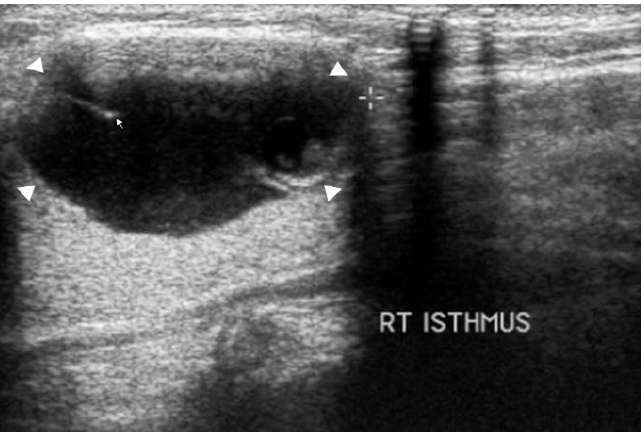
Figure 14. Neck ultrasound of enlarged cervical lymph nodes from a patient with papillary thyroid cancer. The enlarged node is oval in shape, very hypoechoic and contains a few of the blotchy microcalcifications typical of papillary cancer. The arrow heads indicate the corners of the node. The little arrow inside referring to an echogenic focus.